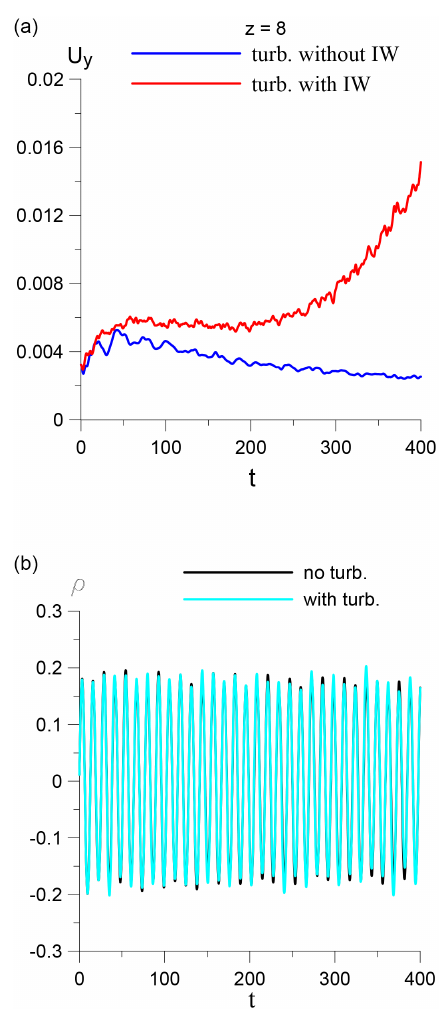
Figure 5. (a) Temporal development of rms velocity component U (cid:48) y obtained at level z = 8 in DNS with initially excited turbulence and an IW propagating in the pycnocline. Temporal development of tur- bulence rms velocity in the absence of IW is also shown for com- parison. (b) Temporal development of the instantaneous density de- viation at the point with coordinates x = 20, y = 10 and z = 8 (in the middle of the pycnolcine) obtained in DNS with initially excited IW with and without